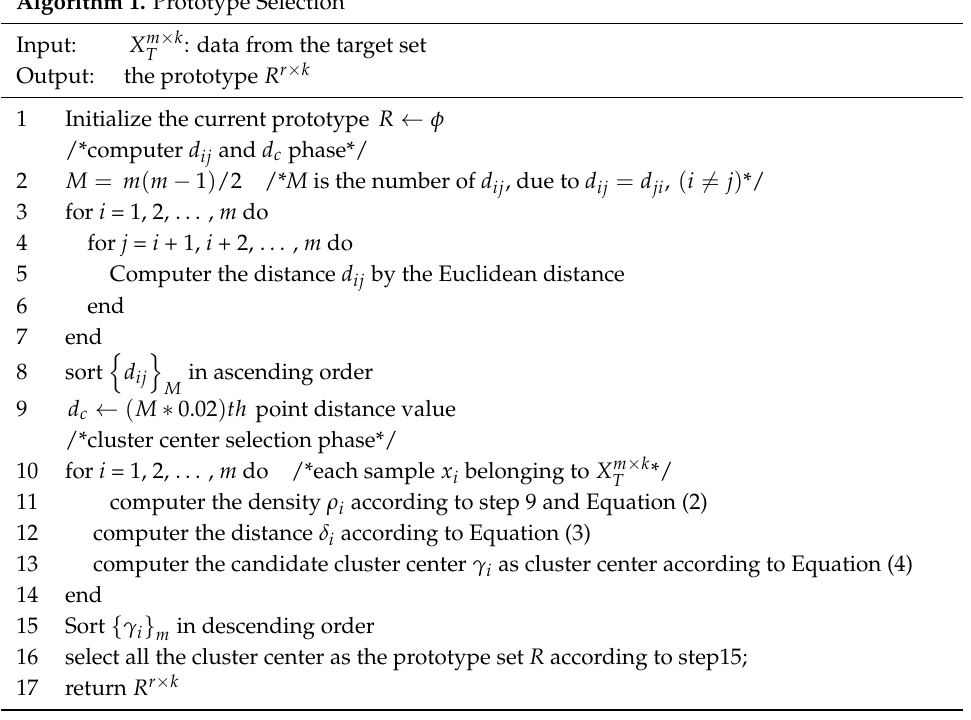
Algorithm 1. Prototype